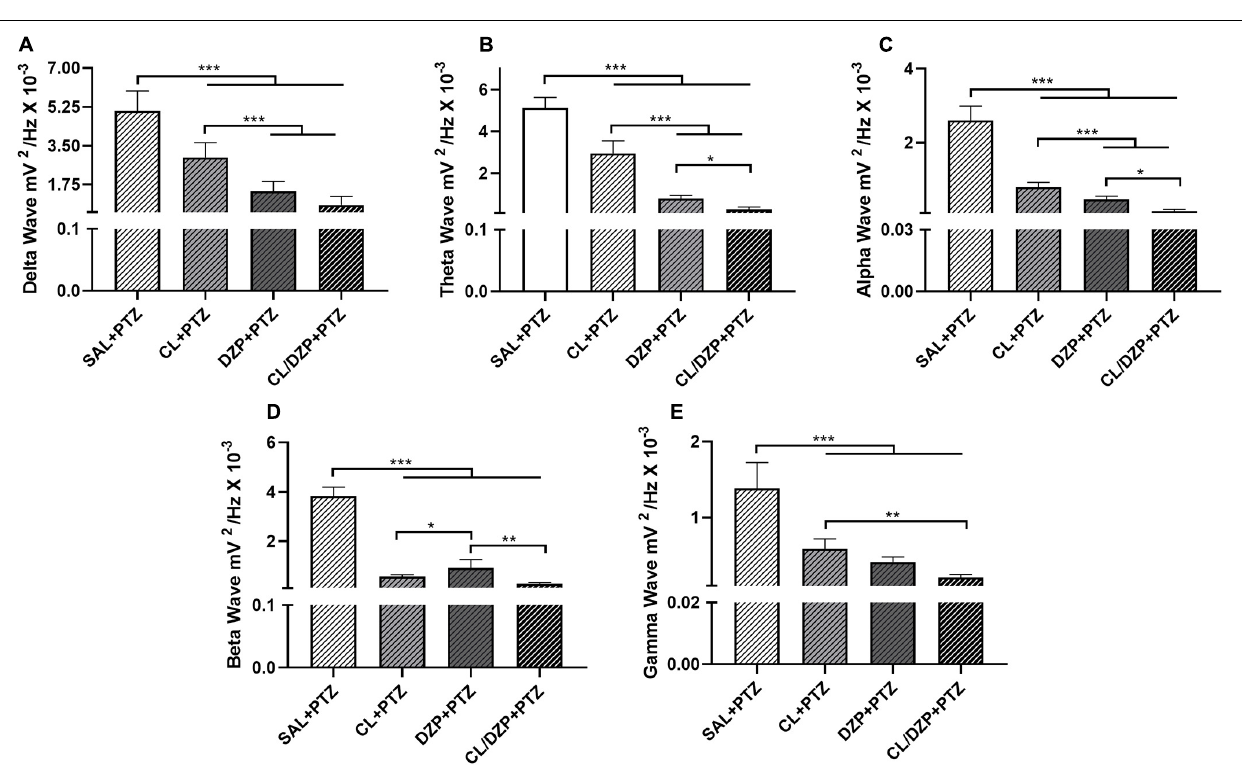
FIGURE 4 | Relative bandpower of the brainwaves (1–40 Hz) of the animals that received pentylenetetrazol on the fifth day (PTZ groups). Quantitative electroencephalographic data on the relative bandpower of the (A) delta waves; (B) theta waves; (C) alpha waves; (D) beta waves; (E) gamma waves. The data are expressed as the mean ± SD ( n = 9 animals per group); * p < 0.05, ** p < 0.01, *** p < 0.001. SAL, saline; CL, Curcuma longa ; DZP, diazepam; PTZ,